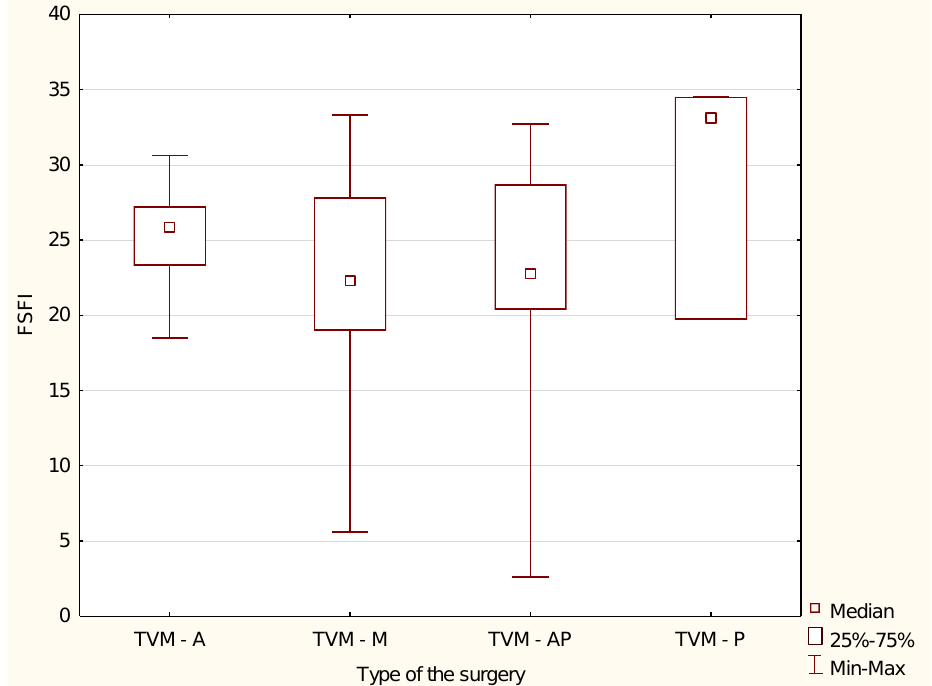
Figure 2. Median and range of FSFI results after VNTR depending on the type of surgery. A-C— anterior colporraphy; P-C—posterior colporraphy; AP-C—anterior and posterior colporraphy; F-O—Fothergill’s operation.